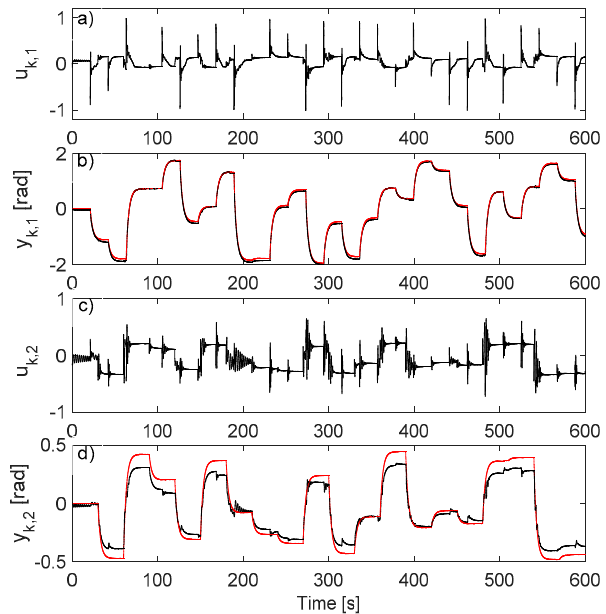
Figure 4. AI-VIRL NN controller: ( a ) u k ,1 ; ( b ) y k ,1 (black), y m (red).